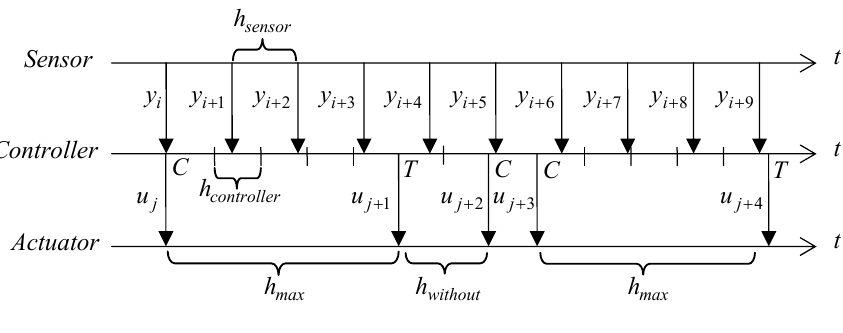
Figure 5. Exchange of information between sensor, controller, and actuator in the hybrid approach where h = 5 × h . The C represents when the control action is calculated max controller because the error-based condition becomes true, and the T represents when the controller acts by time because h ≥ h withou t max